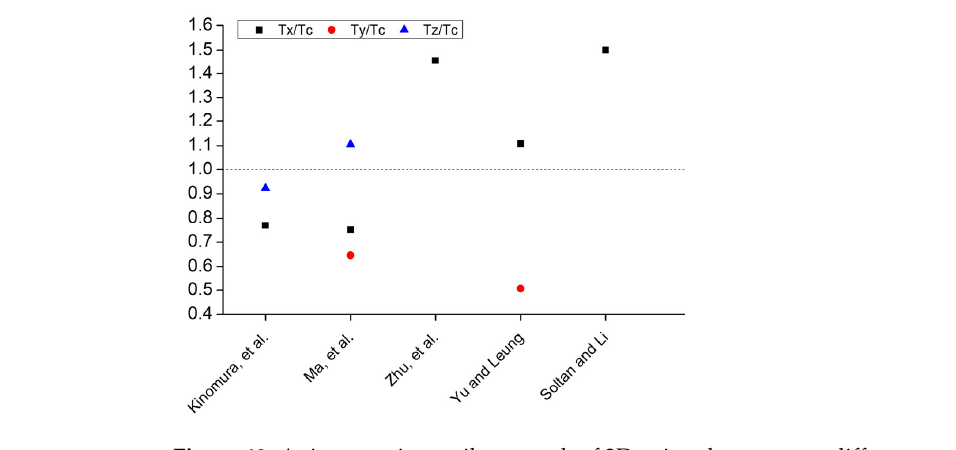
Figure 14. Frequency distribution of the ratio of flexural strength to the compressive strength in casted and printed con- crete at different test directions.